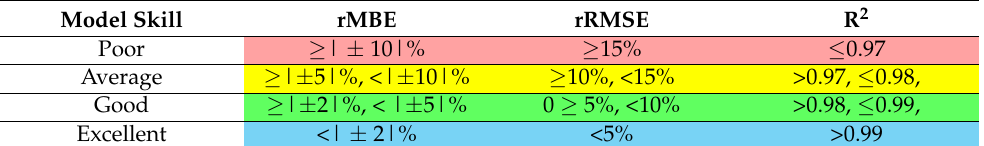
Table 2. Four performance categories to classify clear sky GHI models. The colours in the table are used to visualize the model skill in addition to statistical thresholds with blue representing excellent performance, green good performance, yellow average performance and pink poor performance